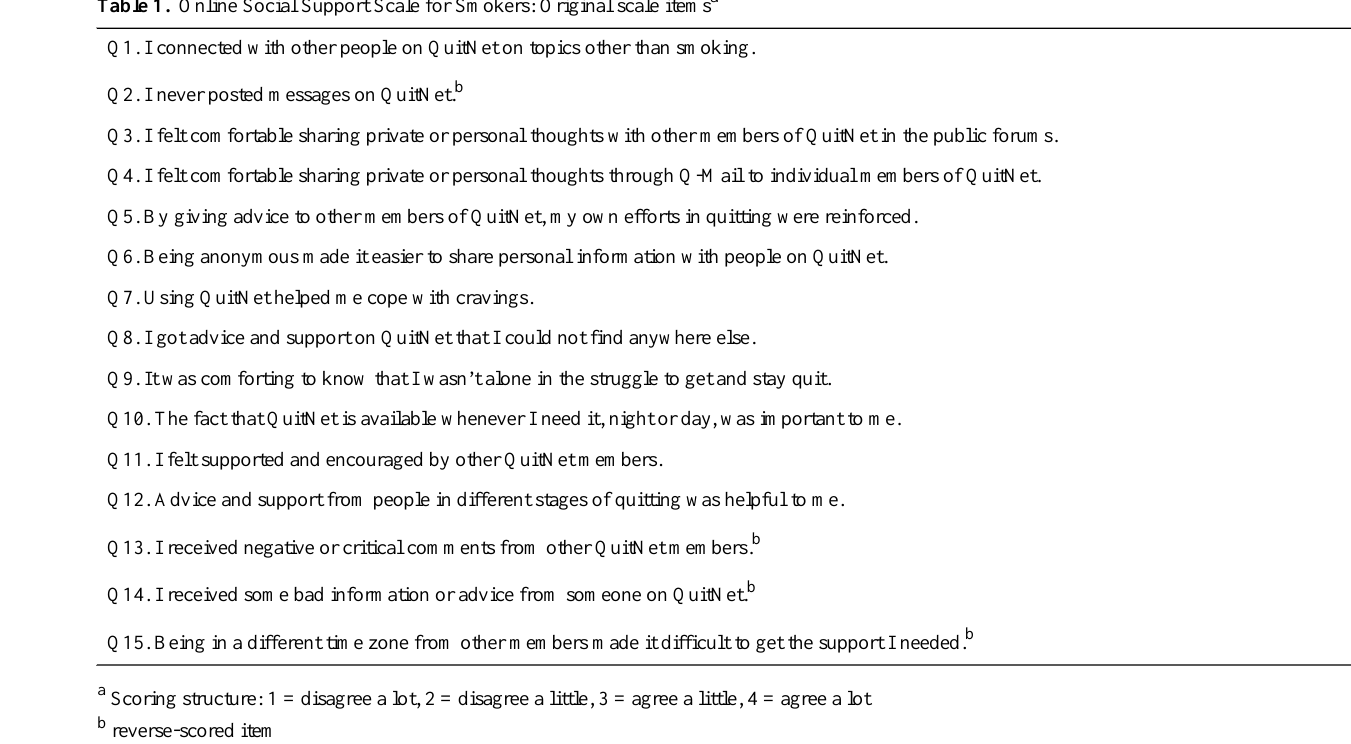
Table 1. Online Social Support Scale for Smokers: Original scale items